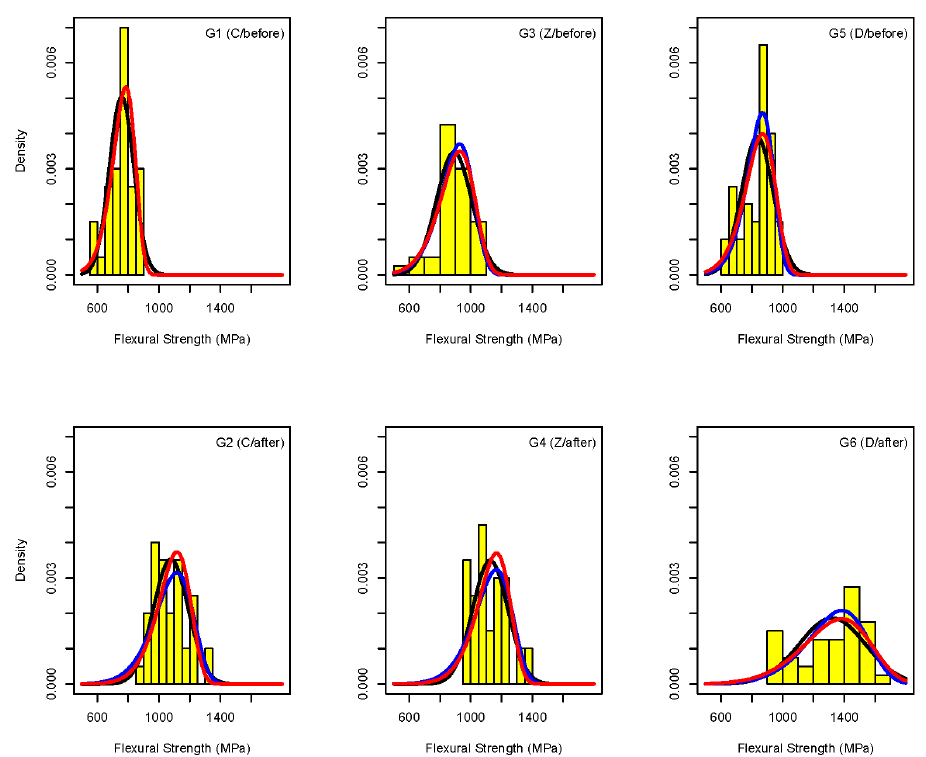
Figure 4. Histogram of biaxial flexural strength with superimposed densities: Weibull estimated by ML ( blue ) and YonX/hazen ( red ) and Normal ( black ). Factor G and levels of ZM/SP are indicated on top of each plot.